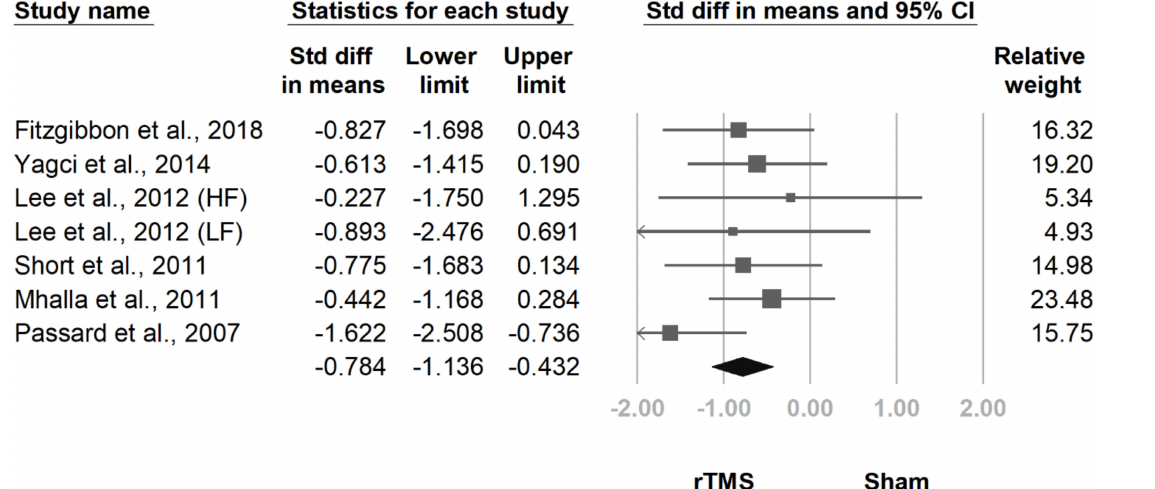
Figure 5. Forest plot of standardized mean differences in Fibromyalgia Impact Questionnaire at follow-up 2 weeks to 1 month after last treatment session. Squares indicate effect sizes of individual studies, lines indicate 95% CI, and diamond indicates the summarized effect size.